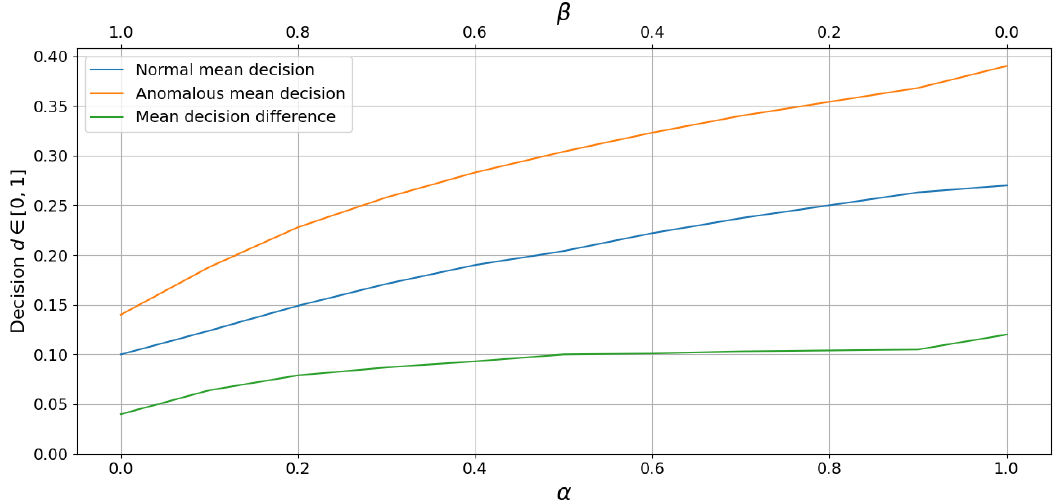
Figure 5. Mean normal and anomalous decisions for α + β =